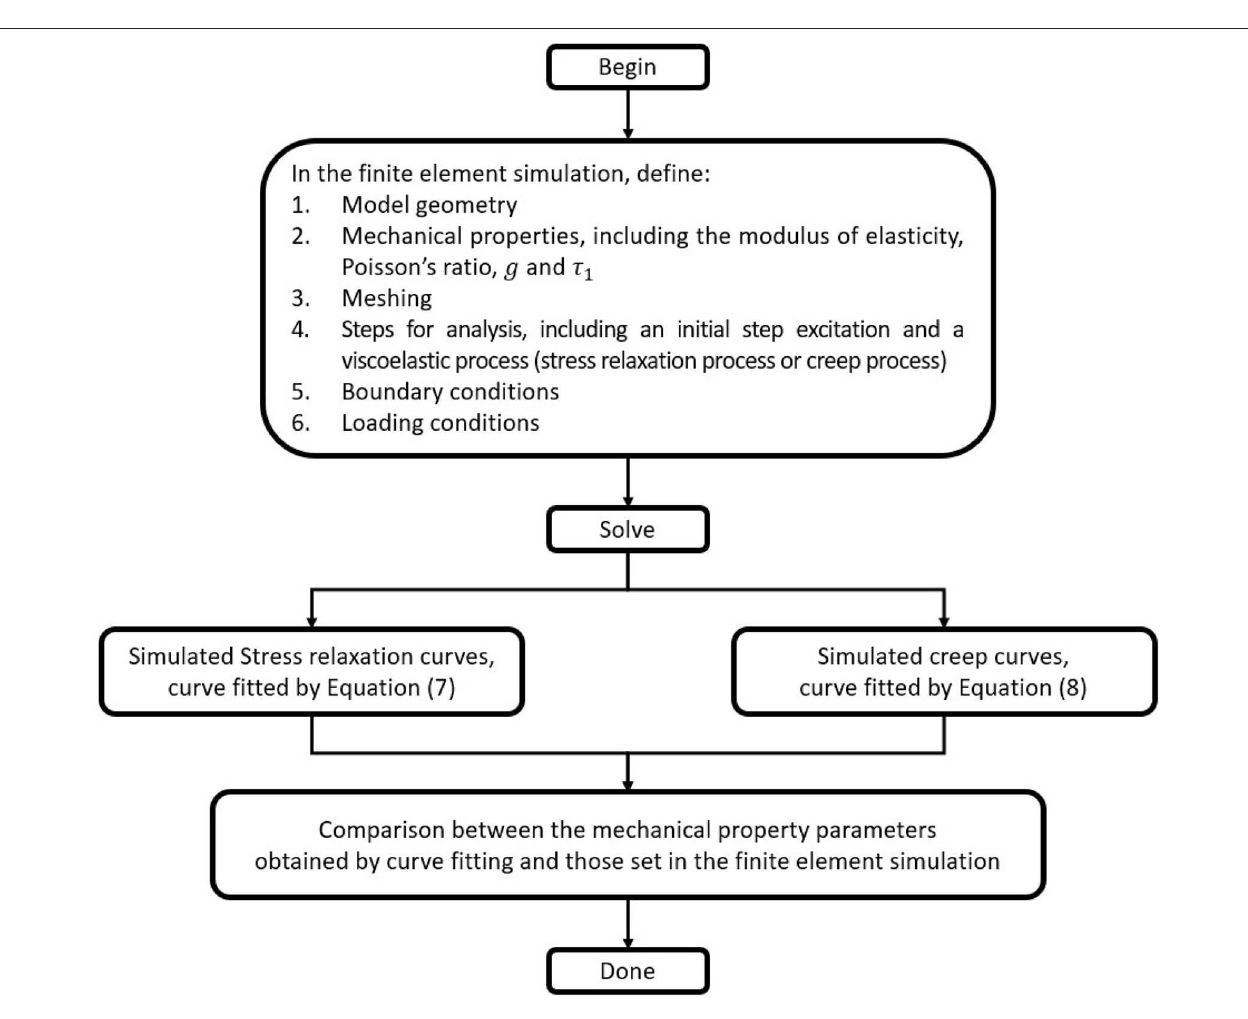
FIGURE 4 | Flowchart of the finite element simulation and numerical analysis.